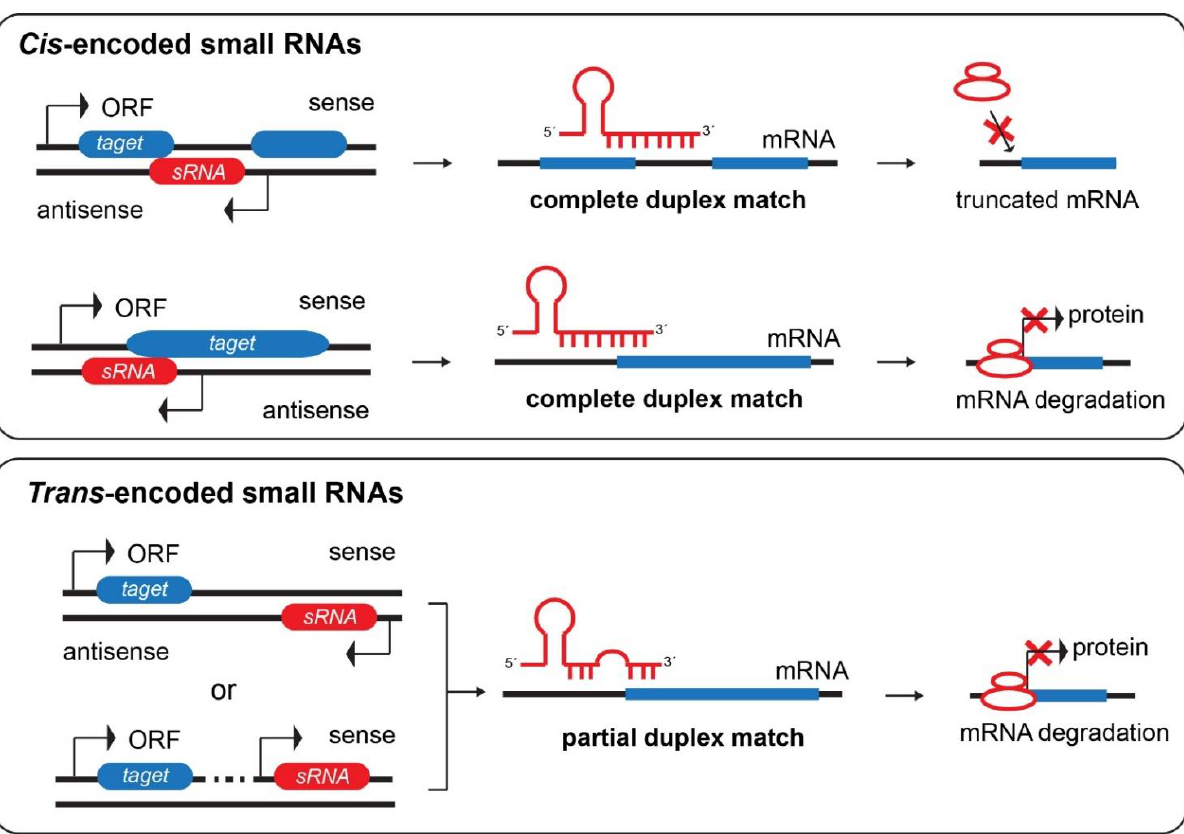
Figure 1. Cis -encoded small RNAs are transcribed from the complementary strand of the prokaryotic genome and from the same genetic loci of their target genes. They show high complementarity with their mRNA targets and regulate the maintenance and the stability of RNA transcripts, by inhibiting translational repression or by inducing RNA degradation and cleavage. Trans -encoded small RNAs are transcribed from DNA sense and antisense genes, from different genomic locations compared to their target genes. They show partial complementarity with their target genes. Their binding to mRNA targets inhibits protein translation or induces mRNA degradation.